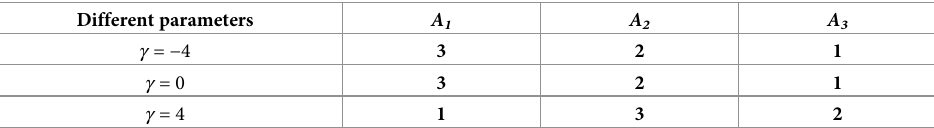
Table 12. A comparison of the orders of the alternatives of Example 2 for different parameters.